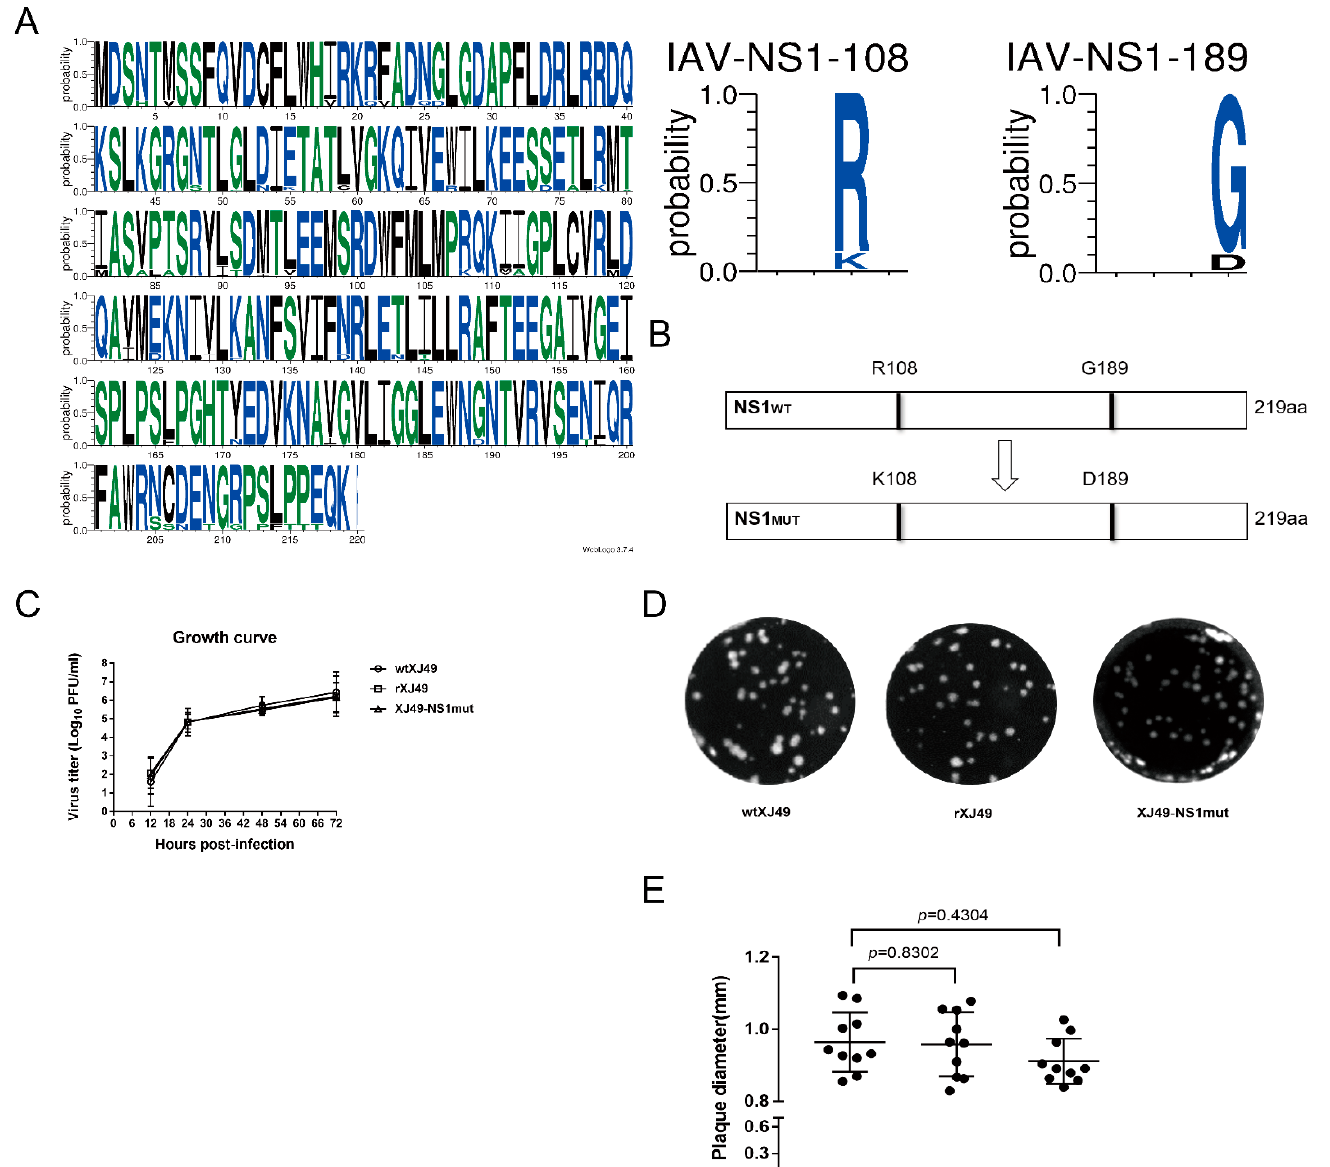
Figure 1. Characterization of the recombinant XJ49-NS1mut influenza virus. ( A ) Sequence logo describing sequence conservation at position 108 and 189 of the NS1 protein of the H1N1 virus (http://weblogo.threeplusone.com/create.cgi, accessed on 15 March 2020). ( B ) Schematic representation of the WT NS1 protein and the mutant NS1 protein harboring the R108K and G189D mutations. ( C ) Growth kinetics of the WT and recombinant XJ49-NS1mut viruses. MDCK cells were infected with wtXJ49, rXJ49, or XJ49-NS1mut at a MOI of 0.01. Supernatant was collected at 12, 24, 48, and 72 h post-infection, and the viral titer measured in a plaque assay. The mean yields and standard error of triplicate experiments are shown. ( D ) Plaque morphology and ( E ) average plaque size ( n = 10 per virus). MDCK cells were infected with either WT or recombinant virus, and plaques were visualized by staining with crystal violet. There is no statistical difference ( p : 0.8302, wtXJ49 vs. rXJ49; p : 0.3182, rXJ49 vs. XJ49-NS1mut; p : 0.4304, wtXJ49 vs. XJ49-NS1mut). Statistical analysis was performed using a two-tailed Student t -test ( p < 0.05; p < 0.01).